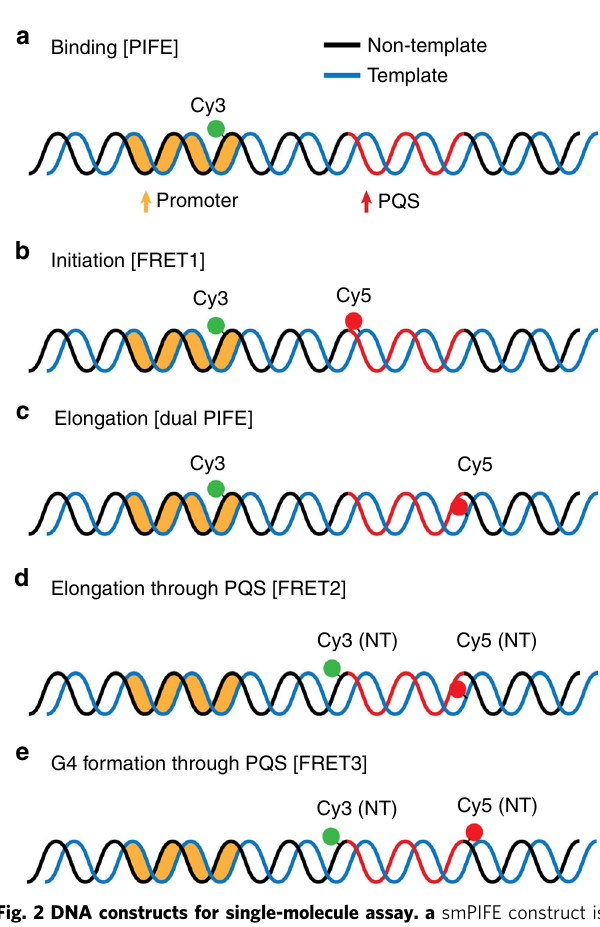
Fig. 2 DNA constructs for single-molecule assay. a smPIFE construct is labeled Cy3 at promoter. b smFRET1 construct with both dyes upstream of PQS. c Dual-PIFE construct is labeled Cy3 at promoter and Cy5 downstream of PQS. d smFRET2 construct with Cy3 and Cy5 in the non- template and template strand, respectively. e smFRET3 construct with both dyes in the non-template strand. Template, non-template strand, and promoter are colored in blue, black, and orange, respectively. PQS is shown as red in non-template, for